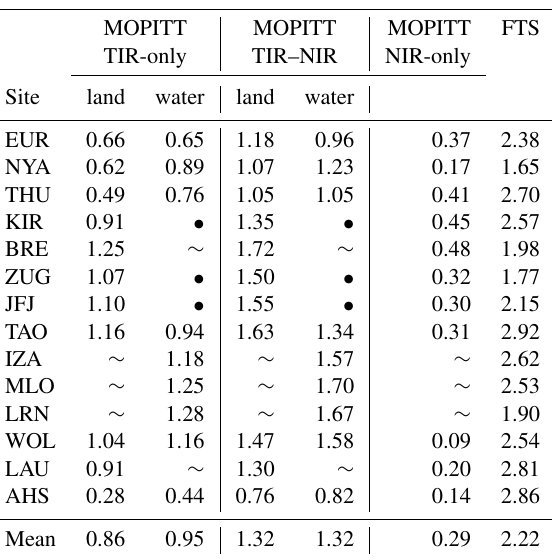
Table 2. Information content described by median DFS for differ- ent MOPITT products and FTS measurements at each station. DFS is calculated over approximately the same altitude range for each instrument from the surface to approximately 26hPa. DFS are cal- culated for overlapping time periods between instrument; thus, the number of retrievals correspond to the #obs line in Tables 3a, b, c, and 4. DFS for the FTS are almost identical station-wise for all com- parison ranges, so only the results for TIR-only overlap are